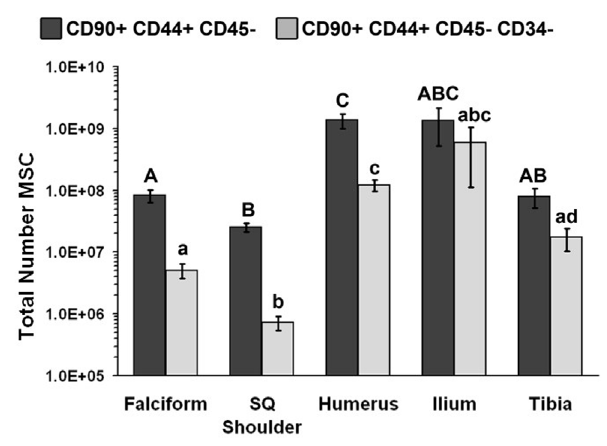
FigUre 1 | Total number of Mscs collected at each site (mean ± sD). Cells were designated as MSCs based on one of the two definitions: definition 1: CD90 + , CD44 + , and CD45 − (A–C); definition 2: CD90 + , CD44 + , CD45 − , CD14 − , and CD34 − (a–d). Different letters above bars indicate significant ( P < 0.05) differences among sites. In other words, those labeled with the same letter are not statistically different. Upper case letters indicate differences based on the analyses of three cell markers, whereas lower case letters indicate differences between analyses of five cell markers. Graph has been log transformed.